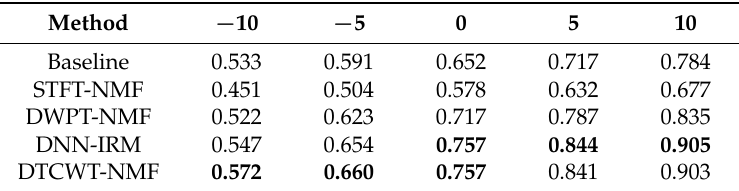
Table 4. The STOI results in five SNR